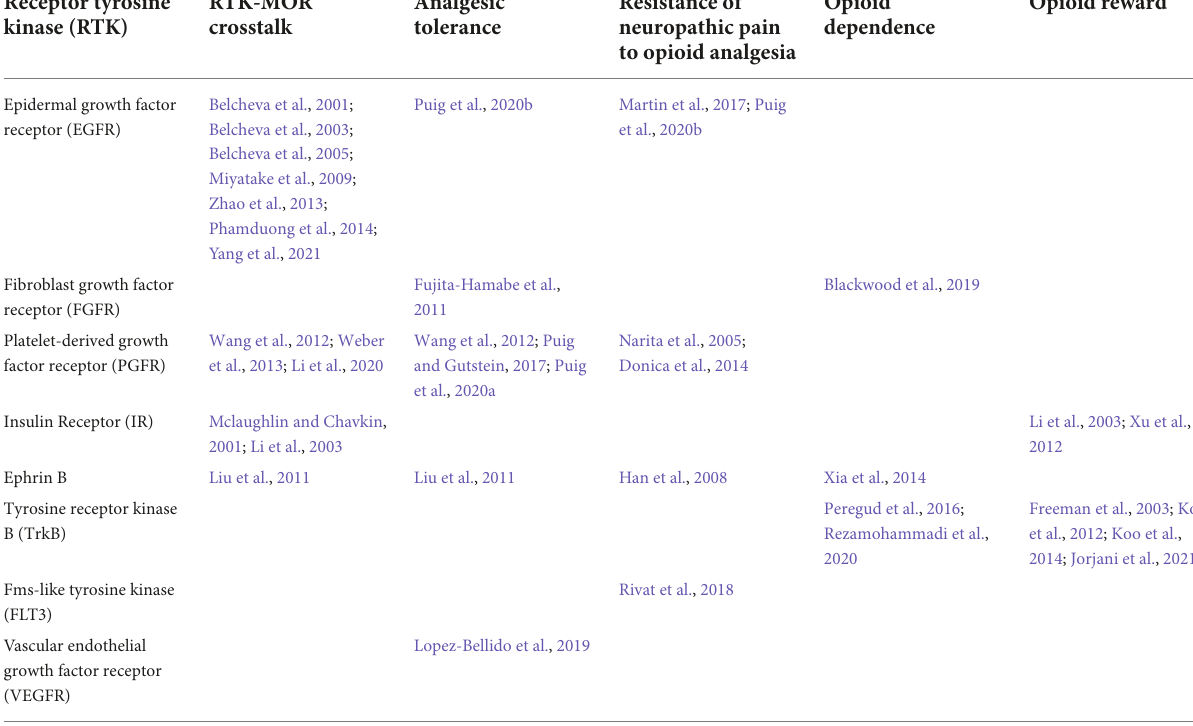
TABLE 1 Receptor tyrosine kinases identified to modulate opioid-mediated behaviors. Receptor tyrosine RTK-MOR kinase (RTK) crosstalk